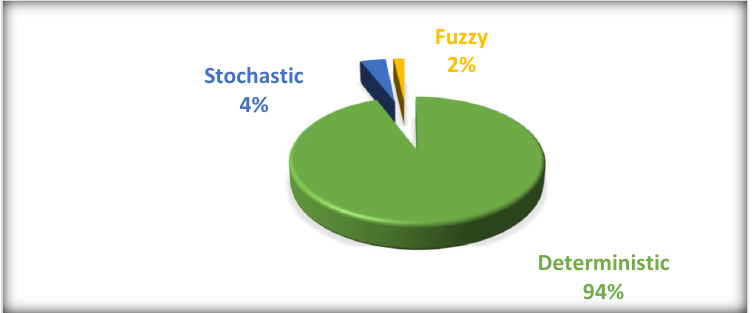
Fig. 21. Percentage distribution of HFS articles according to type of